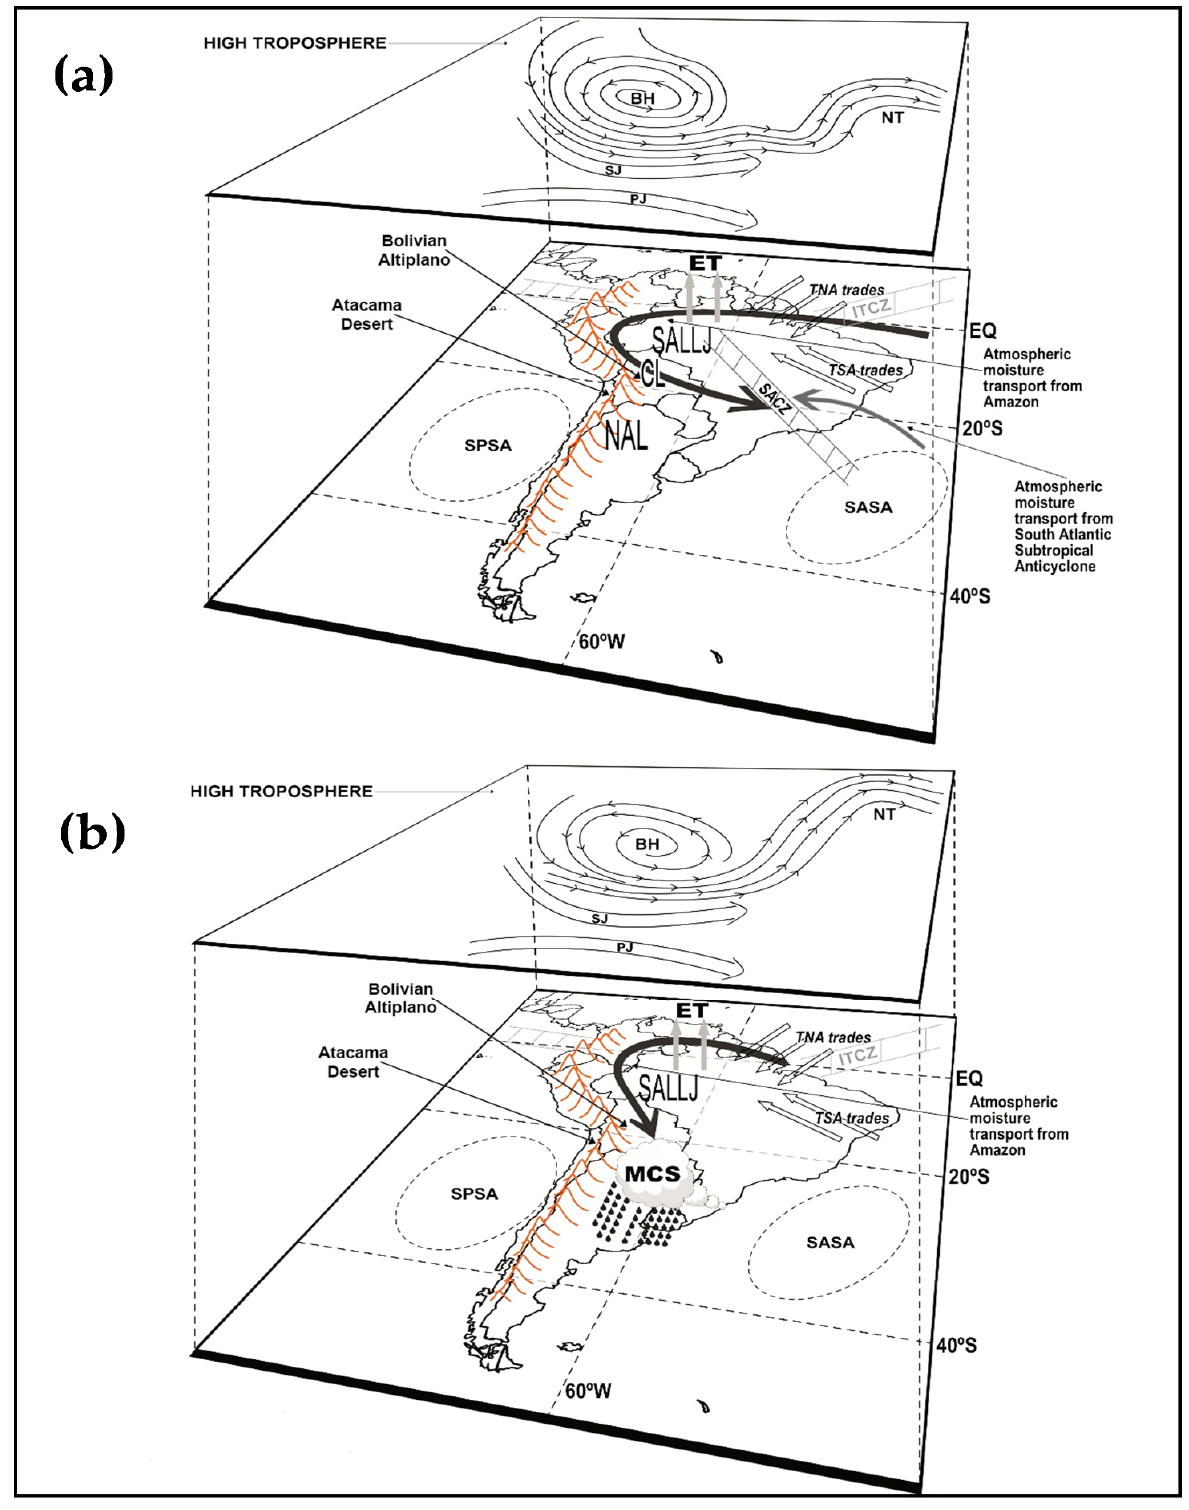
Figure 2. Schematic sketch of important atmospheric circulation features over the South American region, considering events with ( a ) and without ( b ) SACZ. SALLJ = South American low-level jet east of the Andes; TNA trades = tropical North Atlantic trade winds; TSA trades = tropical South Atlantic trade winds; ET = evapotranspiration from Amazon forests; MCS = mesoscale convective system; ITCZ = intertropical convergence zone; SPSA = South Pacific subtropical anticyclone; SASA = South Atlantic subtropical anticyclone; CL = Chaco low; NAL = northwestern Argentinean low; NT = northeast trough; BH = Bolivian High; SJ = subtropical jet; PJ = polar